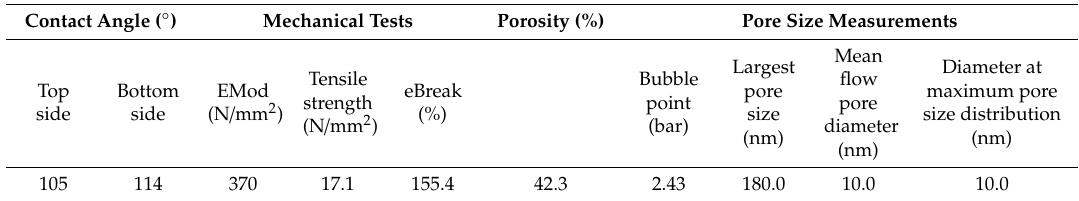
Table 1. Properties of the LMP ECTFE N2 membrane (the relative standard error is less than 5% in all